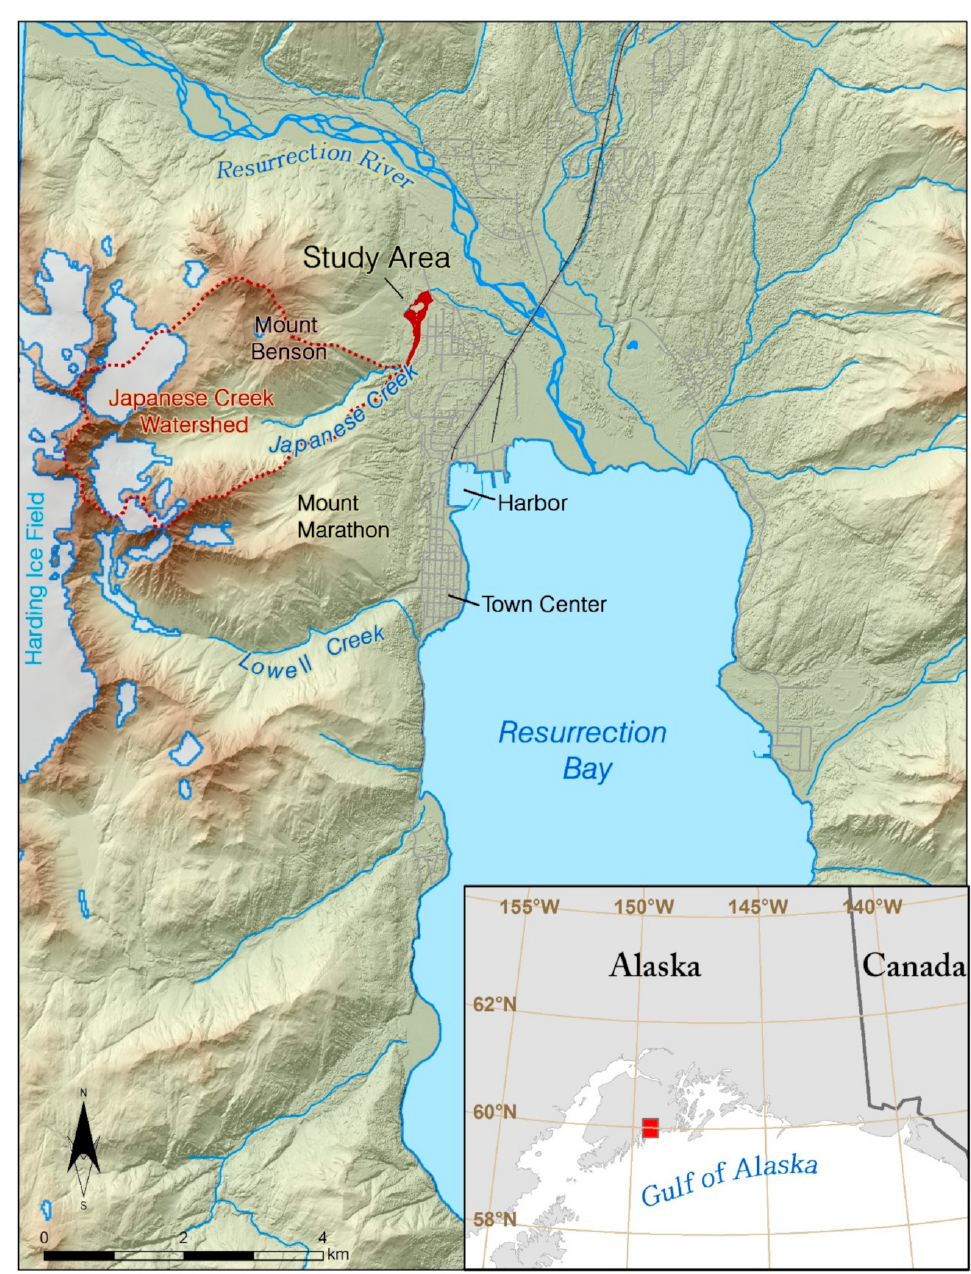
Figure 1. Map of the Resurrection Bay fjord, Seward, Alaska. Seward is located in the fjord-laden south-central coast of Alaska. The city is situated on alluvial fans created from the creeks originating from adjacent valleys, and the delta and flood plain of the Resurrection River. The area of interest for this study is the Japanese Creek reserved stream corridor (in red), which protects the northwest portions of the city from flood waters and debris flows originating from the Japanese Creek watershed to the west (outlined with a red dash